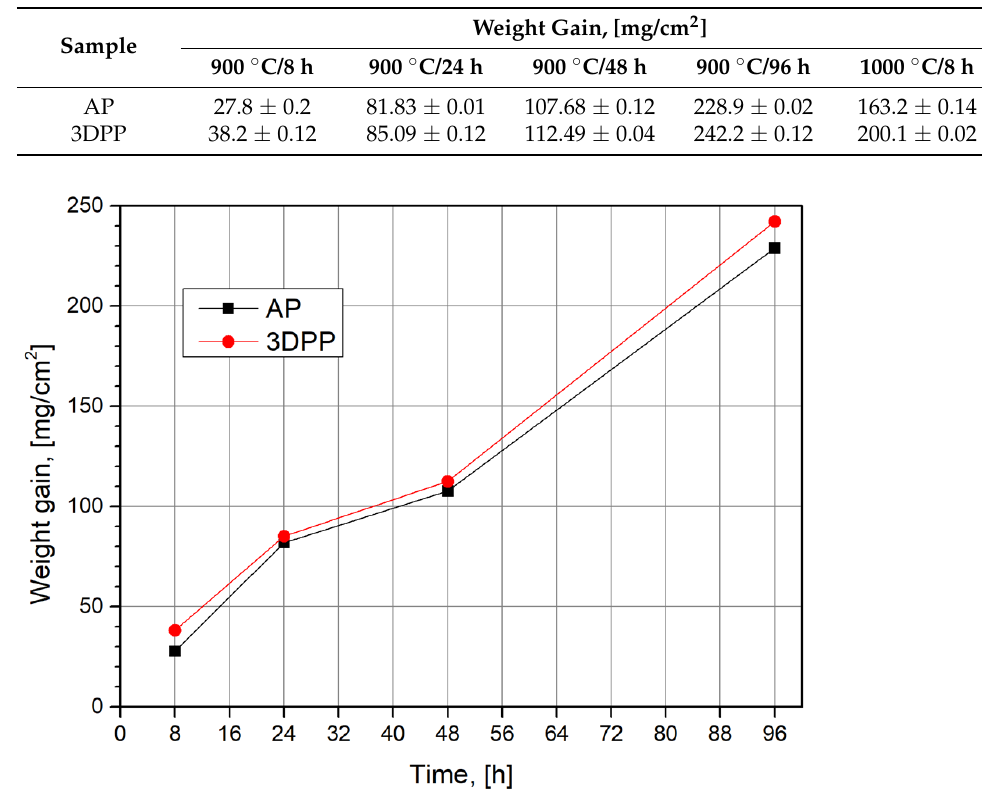
Figure 1. Weight gain vs. time for AP and 3DPP samples at 900 °C. The higher corrosion rate at 1000 ◦ C is due to the salt melting and the formation of basic and acidic fluxes on the surface of samples [42]. Additionally, the reactions are